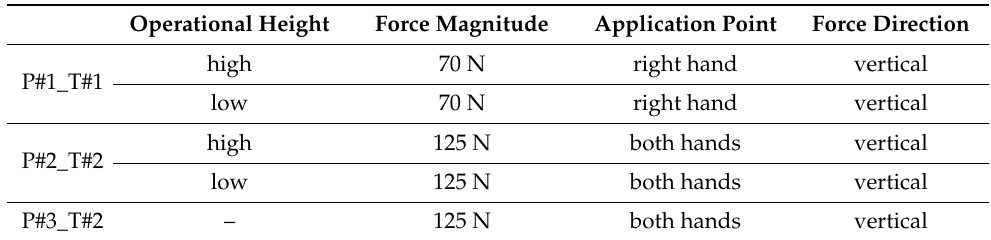
Table 1. The settings at each of the specific postures to estimate the ergonomic results. “P” represents poses. “T” represents